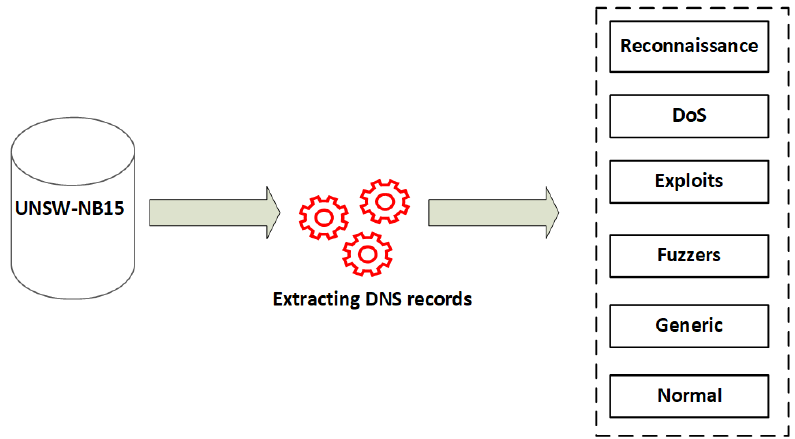
Figure 6. Extracting DNS records from UNSW-NB15